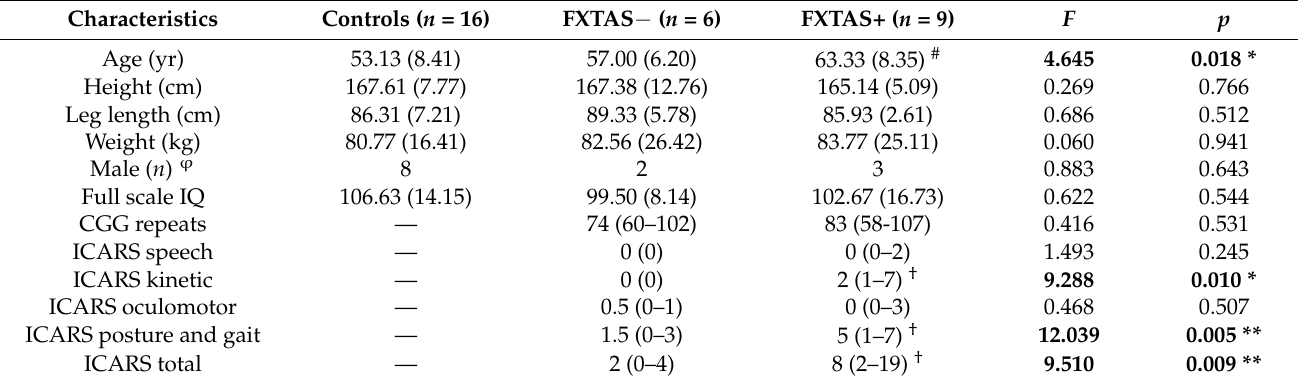
Table 1. Demographics and clinical characteristics of healthy controls and premutation carriers with and without fragile X-associated tremor/ataxia syndrome